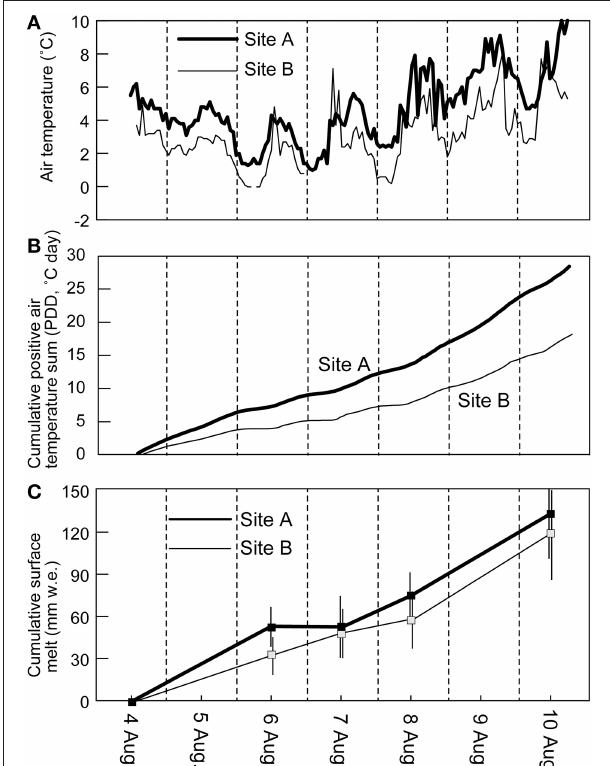
FIGURE 3 | Hourly air temperature (A), cumulative hourly sum of positive air temperature divided by 24h (PDD) (B), and surface melt in water equivalent (C) of Glacier No. 31 recorded at the two sites during the study period (4–10, August) in 2014. Surface melt indicates average values of 7 and 13 stakes at sites A and B, respectively. Error bar indicates standard deviation of stake measurements at each site.